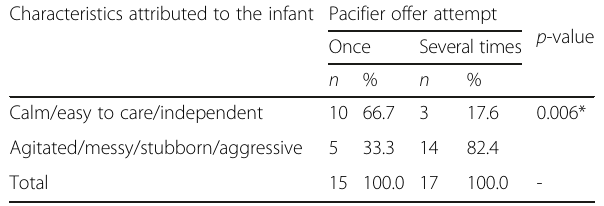
Table 3 Characteristics attributed to the 24-month-olds at the end of the study based on pacifier offer attempt as assessed by their mothers Characteristics attributed to the infant Pacifier offer attempt